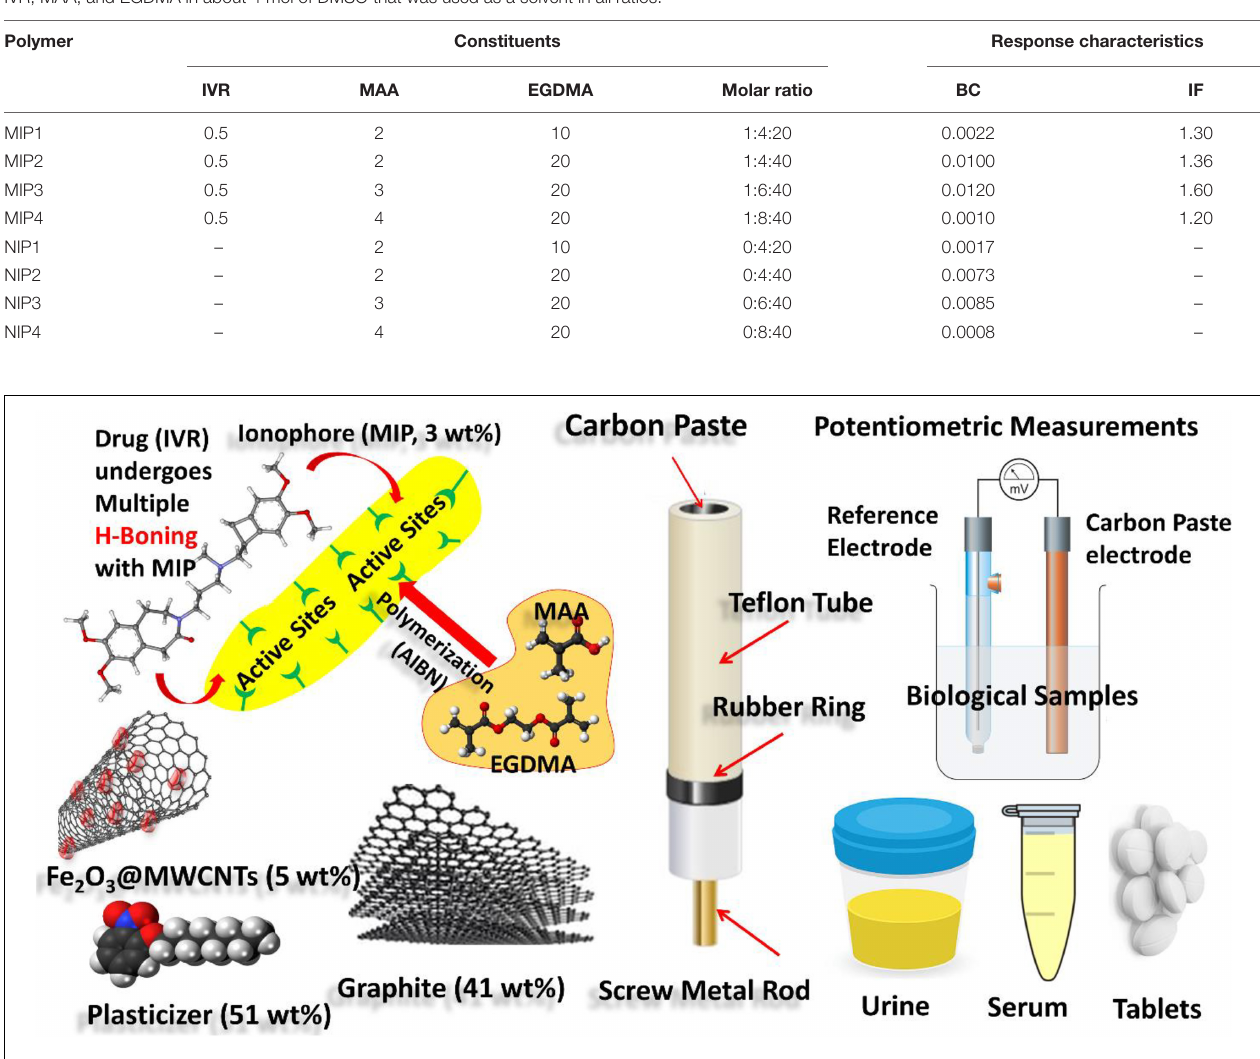
FIGURE 1 | Schematic representation showing experimental work: (i) synthesis of MIPs of IVR drug-using MAA and EGDMA as building monomers and AIBN as initiator; (ii) CPE formulation using graphite as carbon source, MIP as an ionophore for the IVR drug, Fe 2 O 3 @MWCNTs (5 wt%) as a modifier, and NPOE as